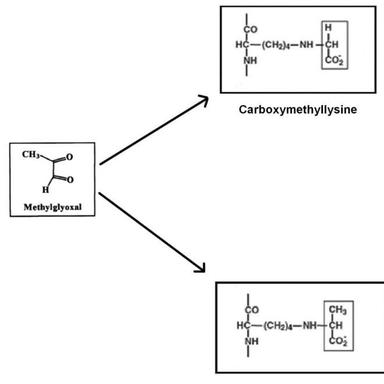
Chemical structure of AGE adducts detected for MG-modified Mb. MGderived AGEs involving lysine residue of the protein (N-carboxymethyllysine, N-carboxyethyllysine) are shown.